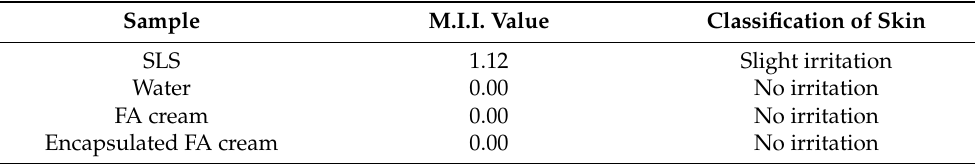
Table 4. The Mean irritation index and skin irritation of volunteers .